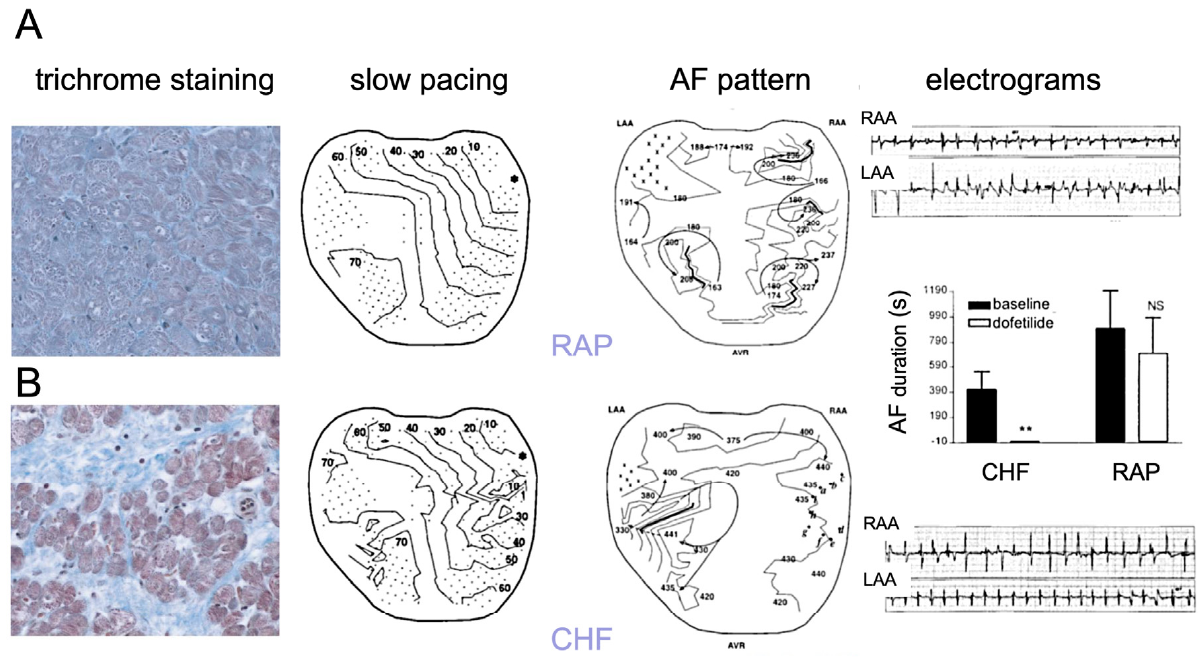
Figure 5. Fibrosis and conduction in dog models of AF. ( A ) In the model with 6–8 weeks of rapid atrial pacing (RAP) mimicking AF, no increase in fibrosis was detected (trichrome staining, left panel), and conduction during pacing was relatively homogeneous (asterisk indicates pacing site). ( B ) By contrast, the model subjected to 5–6 weeks of rapid ventricular pacing, leading to congestive heart failure (CHF), showed pronounced left atrial fibrosis and conduction heterogeneity during pacing. However, during AF, propagation patterns in the RAP models were more complex, with a higher degree of electrogram fractionation, compared to the patterns in the CHF model. The AF duration in the CHF model was also decreased by a larger degree compared to the RAP model (middle panel on the right), adapted from